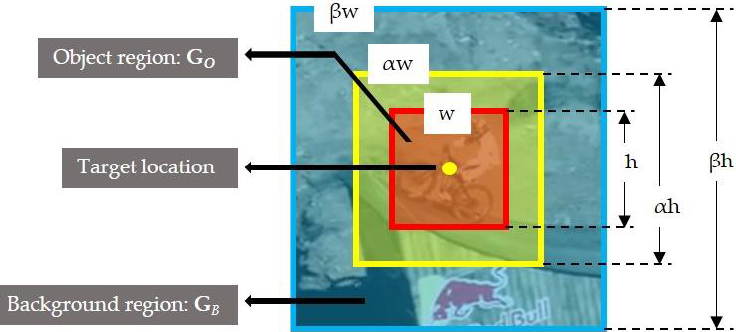
Figure 1. Illustration of the object region.